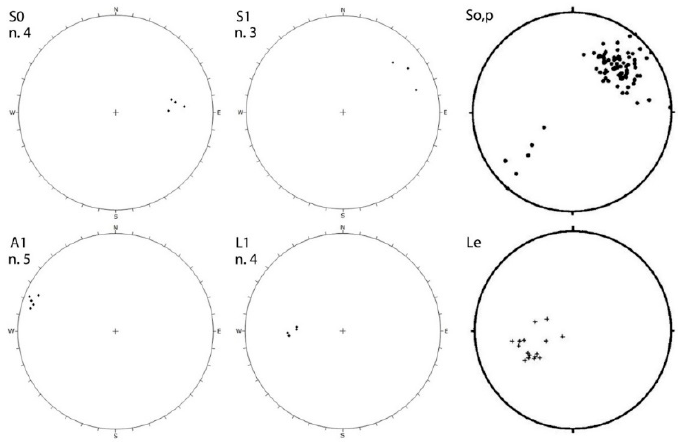
Figure 5. Equal area, lower hemisphere projections of D1 structural elements measured in the study area: S0 sedimentary bedding, S1 foliation, L1 stretching lineation, A1 fold axis. On the right: bedding parallel D1 foliation (p), extension and mineral lineation (Le) (modified from [57]).